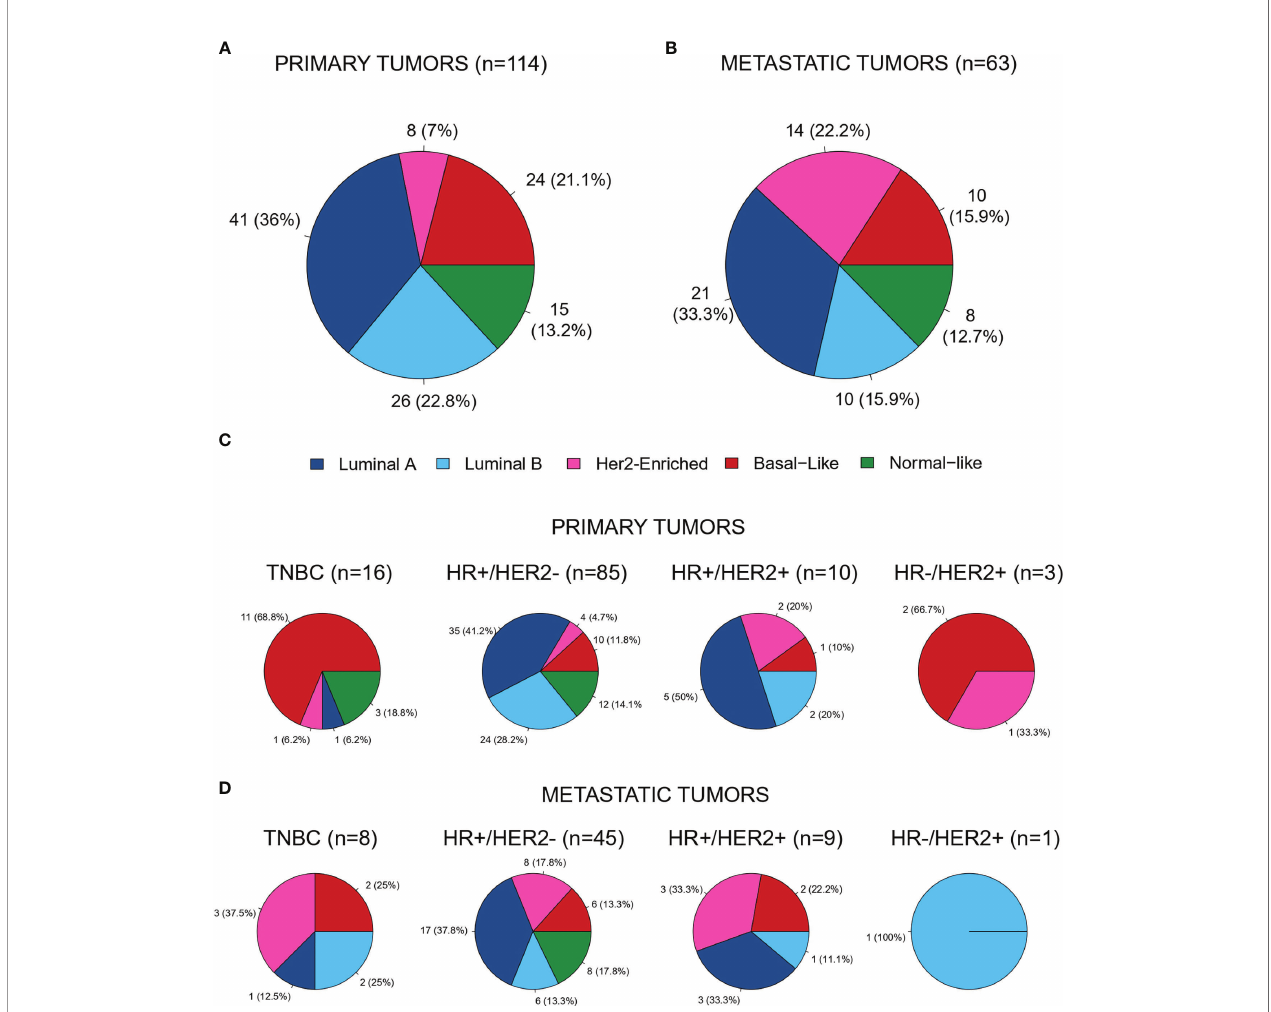
FIGURE 4 | Distribution of the PAM50 intrinsic subtypes in (A) primary tumor samples (n = 114; 64.4%) (B) metastatic samples (n = 63; 35.6%) (C) in primary tumors across immunohistochemistry subtypes and (D) in metastatic tumors across immunohistochemistry